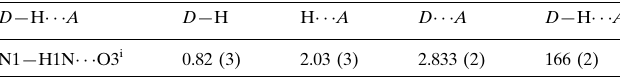
Hydrogen-bond geometry (A˚ , (cid:4)